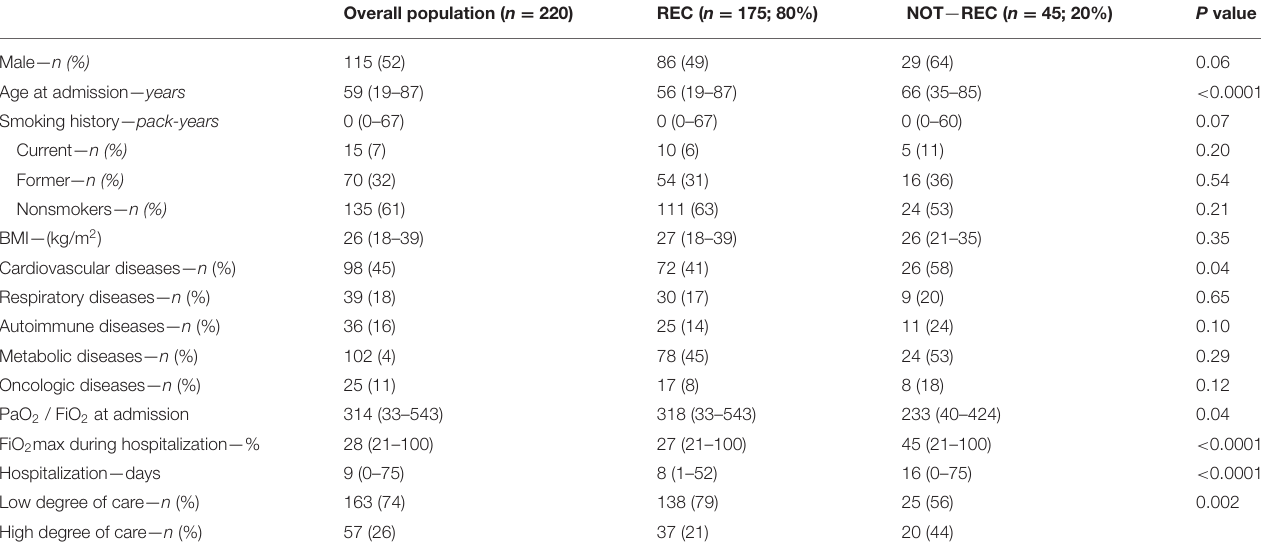
TABLE 1 | Baseline demographics and clinical features of the overall population evaluated at post-COVID clinic, and of the two subgroups categorized according to the presence of radiological recovery during the follow-up period. Overall population ( n = 220) REC ( n = 175; 80%) NOT — REC ( n = 45; 20%)